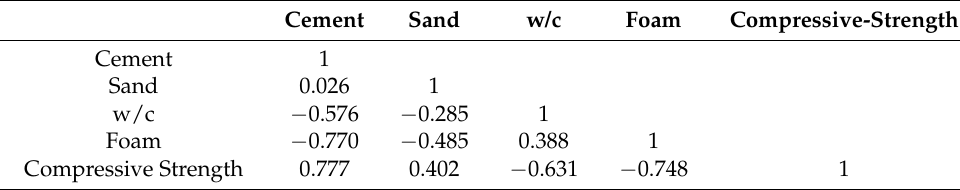
Figure 2. Contour maps of input variables ( a ) cement content; ( b ) sand content; ( c ) w/c ratio; ( d ) foam volume against the compressive strength. Table 2. Pearson-correlation matrix for mix design parameters.